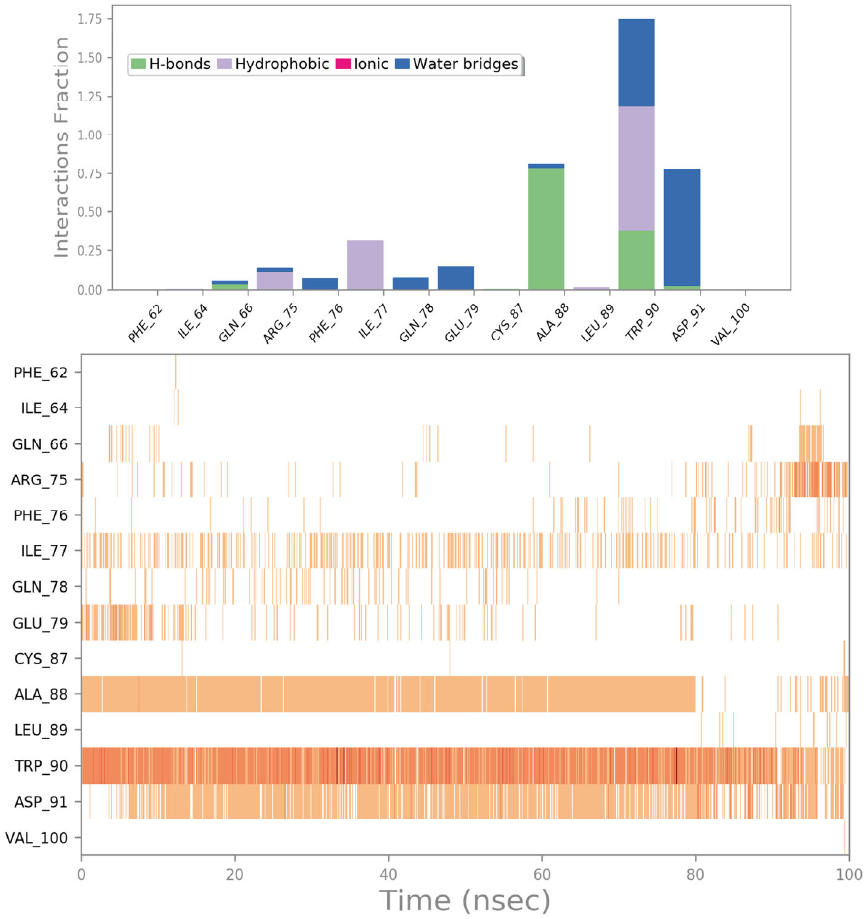
Figure 12. ZINC000018043251 monitored during the MD run. The interactions can be grouped into four types: H bonds (green), hydrophobic (grey), ionic (magenta), and water bridges (blue). The subsequent diagram of the figure illustrates a timeline description of the main interactions. A darker hue of orange indicates that some residues make many distinct contacts with the ligand (Maestro, Schrödinger LLC, release 2020-3).